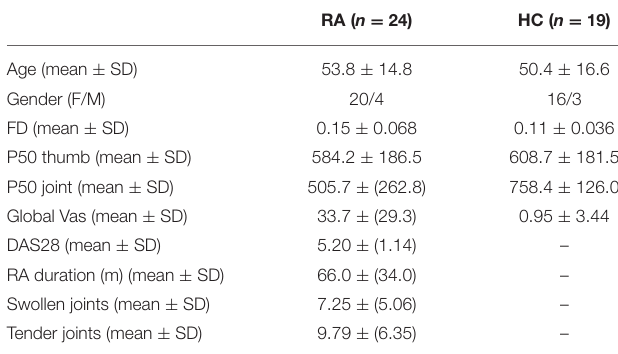
TABLE 1 | Data cohort